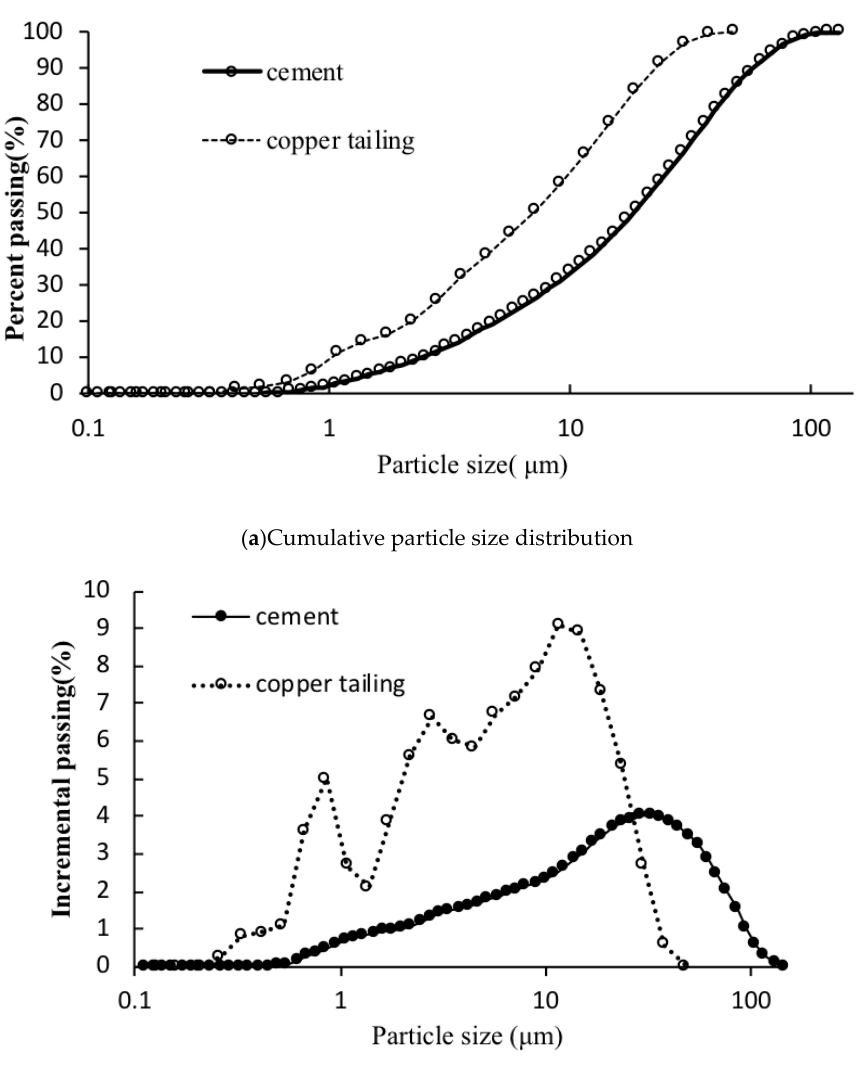
Figure 3. Particle size distribution of raw materials: ( a ) Cumulative particle size distribution; ( b ) interval size distribution.